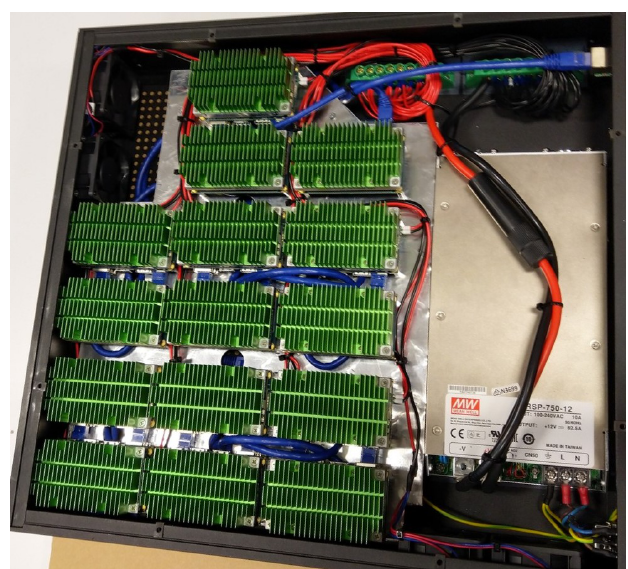
Figure 5. The 3U server version of the visual sensor hosting 15 NVIDIA Jetson TX2 units, each of these computing modules are able to process in real time one live video feed from a CCTV